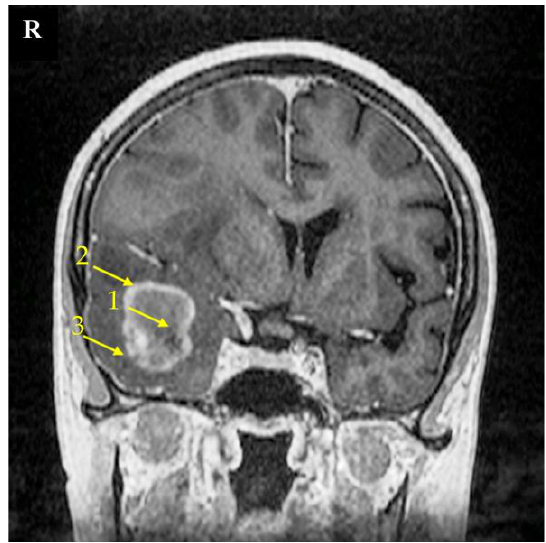
Figure 9. Magnetic resonance imaging (MRI) scan of a brain with the right temporal lobe GBM tumor. This 67-year-old female had reported a two-week-long headache and was administered due to a seizure. MRI imaging shows a non-enhancing tumor core (1), enhancing tumor region (2), and peritumoral area (3). The signs of brain structure shift due to tumor growth expansion are seen as well. The right side of the patient was marked with the letter R.